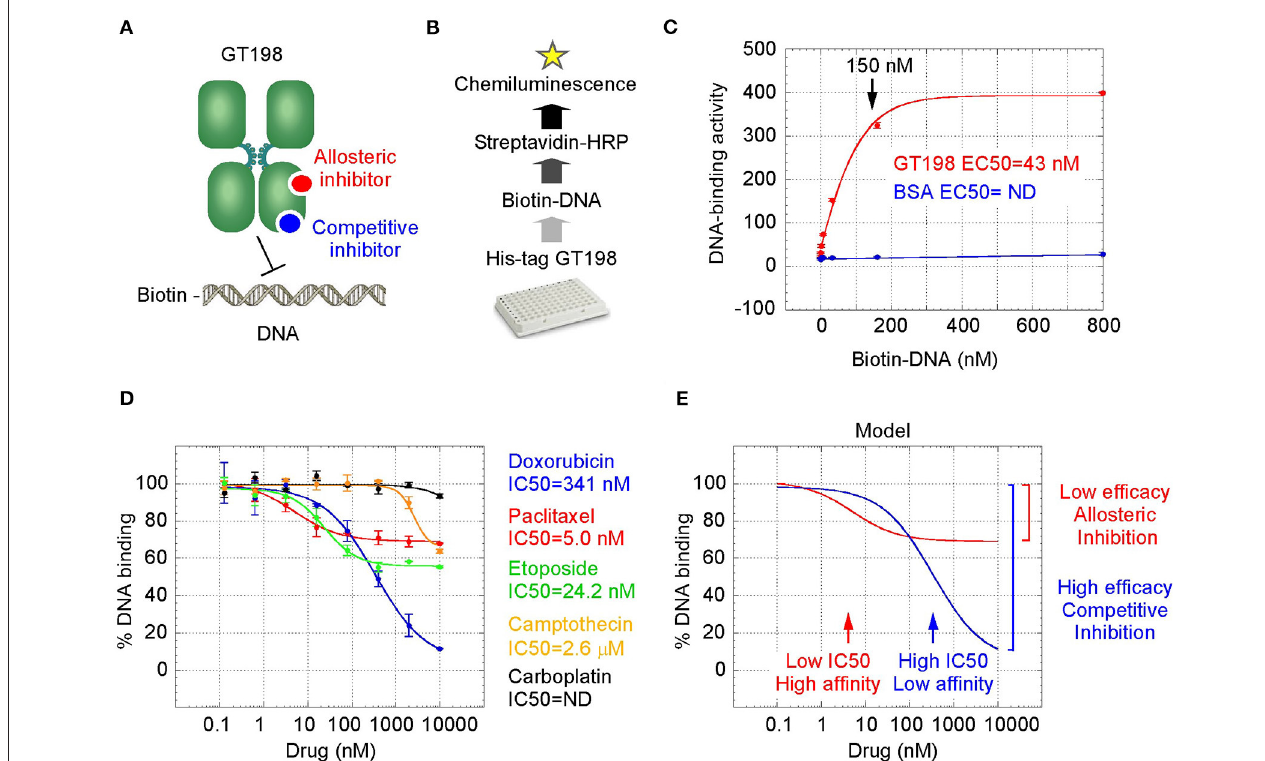
FIGURE 2 | GT198 is a target of oncology drugs. (A) A model of allosteric or competitive drug inhibition of the DNA binding of GT198 dimer. (B) A flowchart of the DNA-binding assay. (C) The increasing concentrations of biotinylated DNA bind to GT198 at EC50 = 43nM using BSA as a negative control. (D) Inhibition of DNA binding to GT198 by increasing concentrations of clinical drugs as indicated. IC 50 s are measured by sigmoidal curve fit. Data represent mean ± s.e.m of duplicate experiments. (E) A graph model comparing binding affinity and